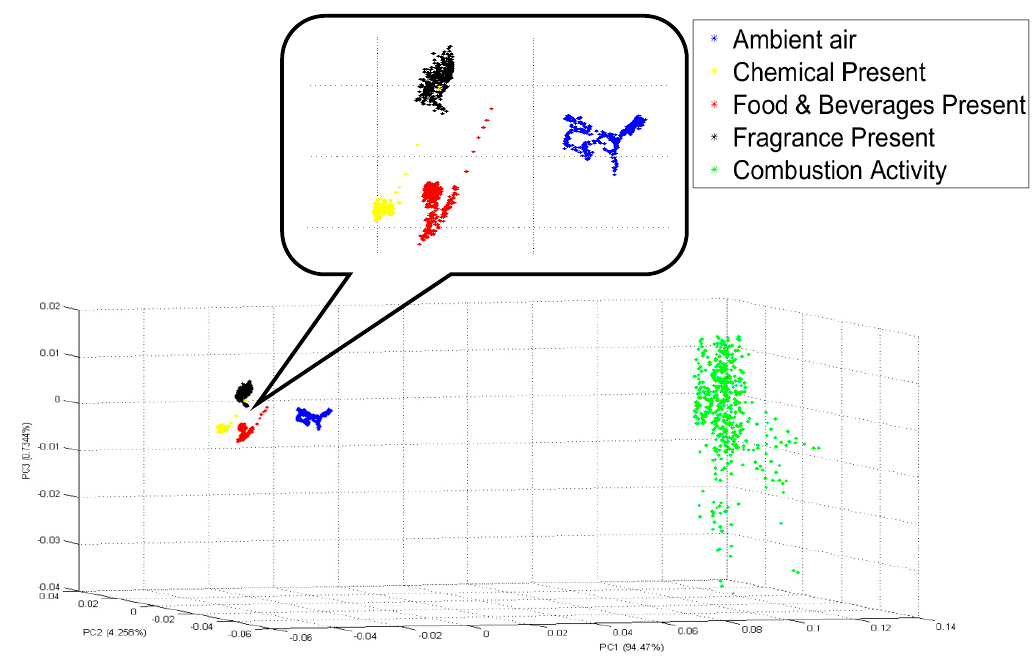
Figure 9. 3D plot of PCA visualization for the VAN feature.